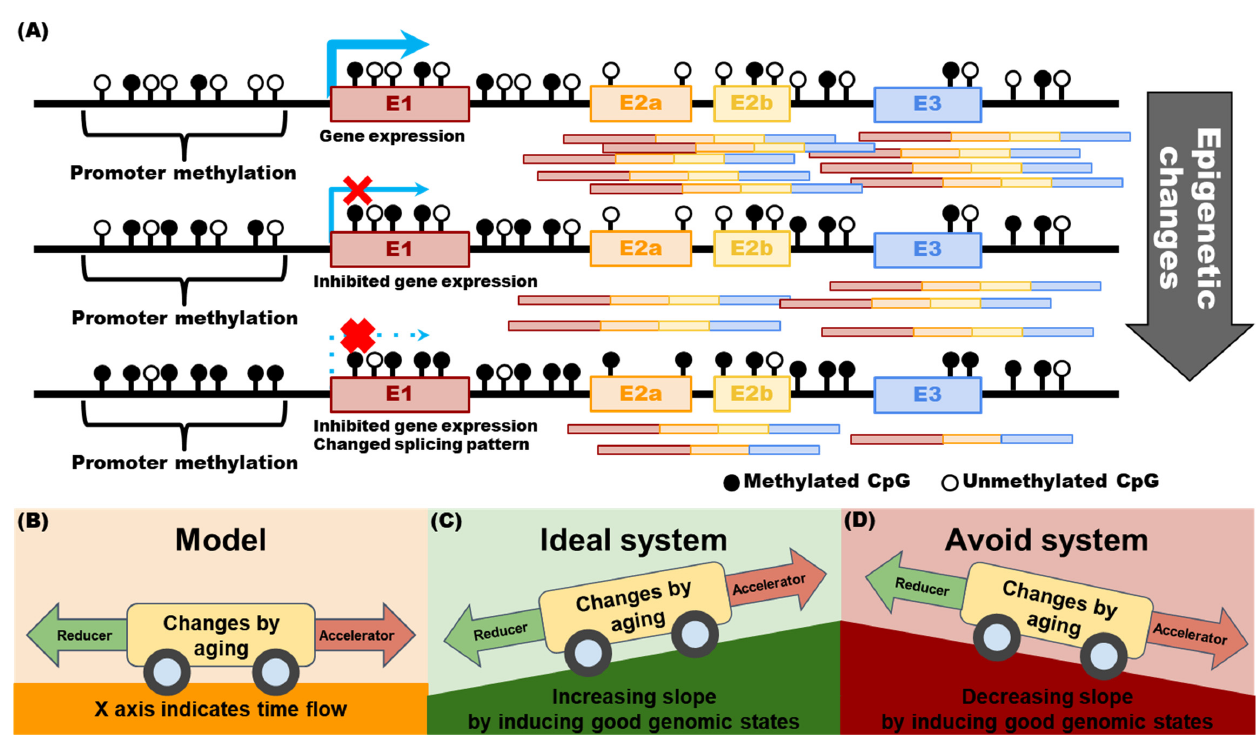
Figure 2. Changes in gene expression and splicing patterns following changes in DNA methylation by aging or disease progression explained via a car model. ( A ) When CpG sites located in the upstream region of the transcription start site are hypermethylated, gene expression decreases. When the CTCF binding site becomes hypermethylated, exon skipping occurs. In this epigenetic pattern change model, as gene hypermethylation increases, the number of transcripts and skipping phenomenon of exon 2b decrease. ( B ) Humans age and undergo changes in DNA methylation patterns over time. Factors that accelerate or reduce aging have been discovered. ( C ) A car model proposing the use of the genomic information management system presented in this review as an ideal system for delaying aging. ( D ) Maintaining detrimental lifestyle habits, irregular and inaccurate health screenings, and improper restrictions by the government on the use of genomic information can accelerate aging.